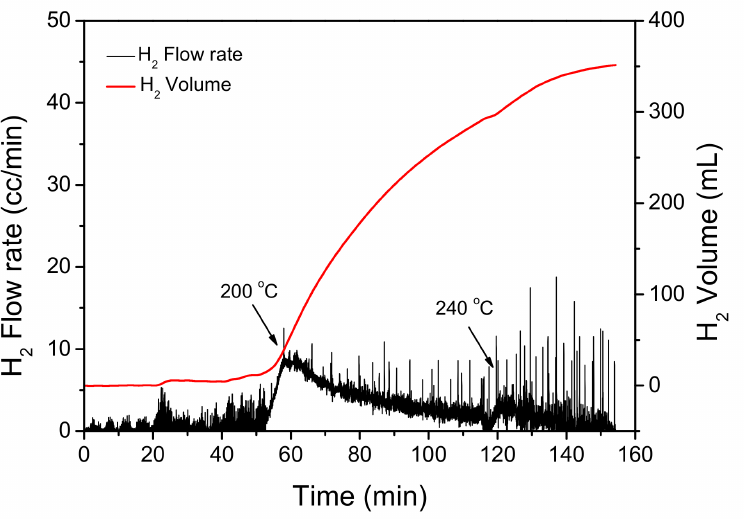
Figure 2. Representative temperature ramping test for dehydrogenation of EBC